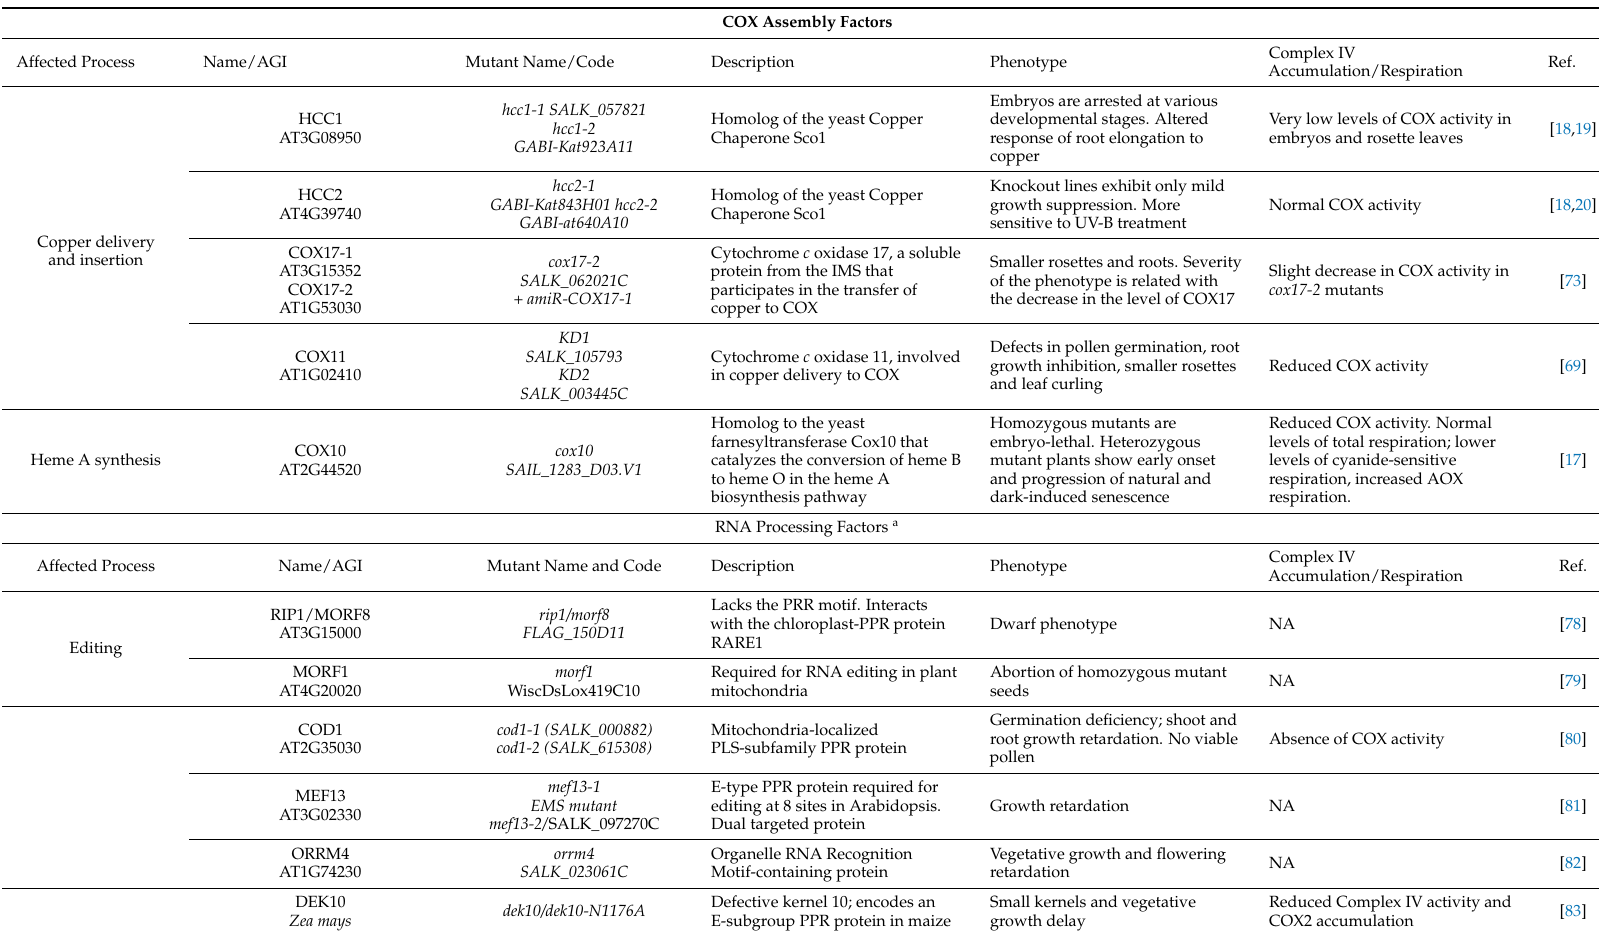
Table 2. Mutants that exhibit COX altered composition and/or